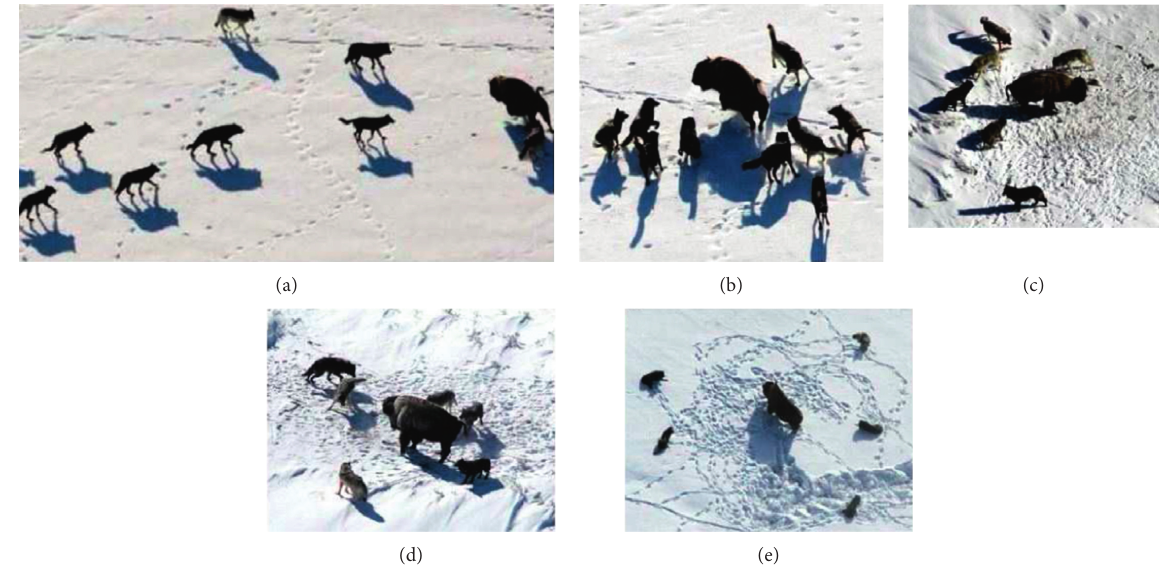
Figure 2: Hunting behavior of grey wolves: (a) chasing, approaching, and tracking prey, (b–d) pursuing, calling, and encircling, and (e) attacking.